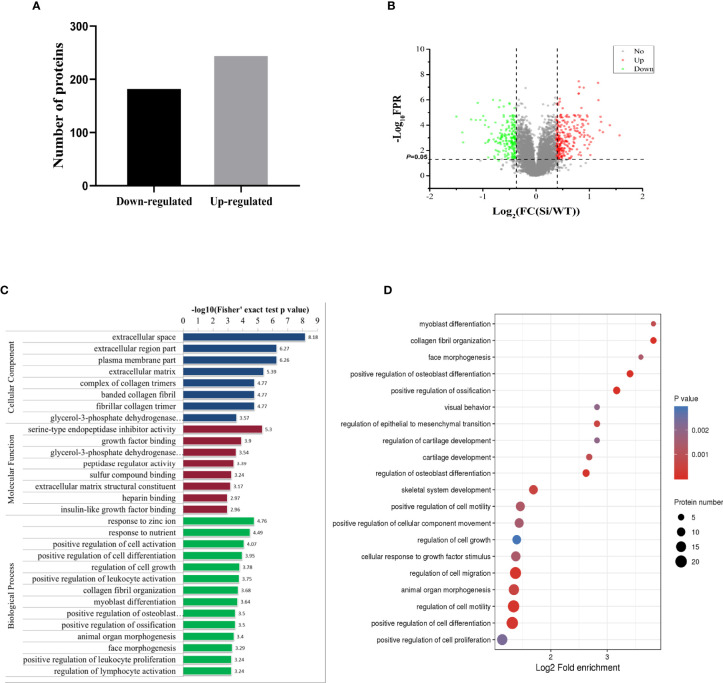
Proteomics analysis of VHL-KD PC12 cell line. (A) A bar graph showed the differential protein analyzed by TMT labeling quantitatively. (B) The volcano map of differentially expressed proteins. The abscissa denotes the ratios of differential expression proteins in the VHL-KD PC12 cell line vs those in the empty vector-transfected cell line; the ordinate represents the P-value between the two groups. (C) Differential protein was analyzed by GO function enrichment, and GO annotations were divided into three categories: Biological Process, Cellular Component, and Molecular Function. (D) The three main categories of differential proteins obtained by GO classification were further functionally analyzed. The circle in the figure indicated the number of differential proteins. The shade of the circle color represented the size of the P value. The darker the color of the circle represented the smaller the P-value; the lighter the color of the circle represented the larger the P-value.